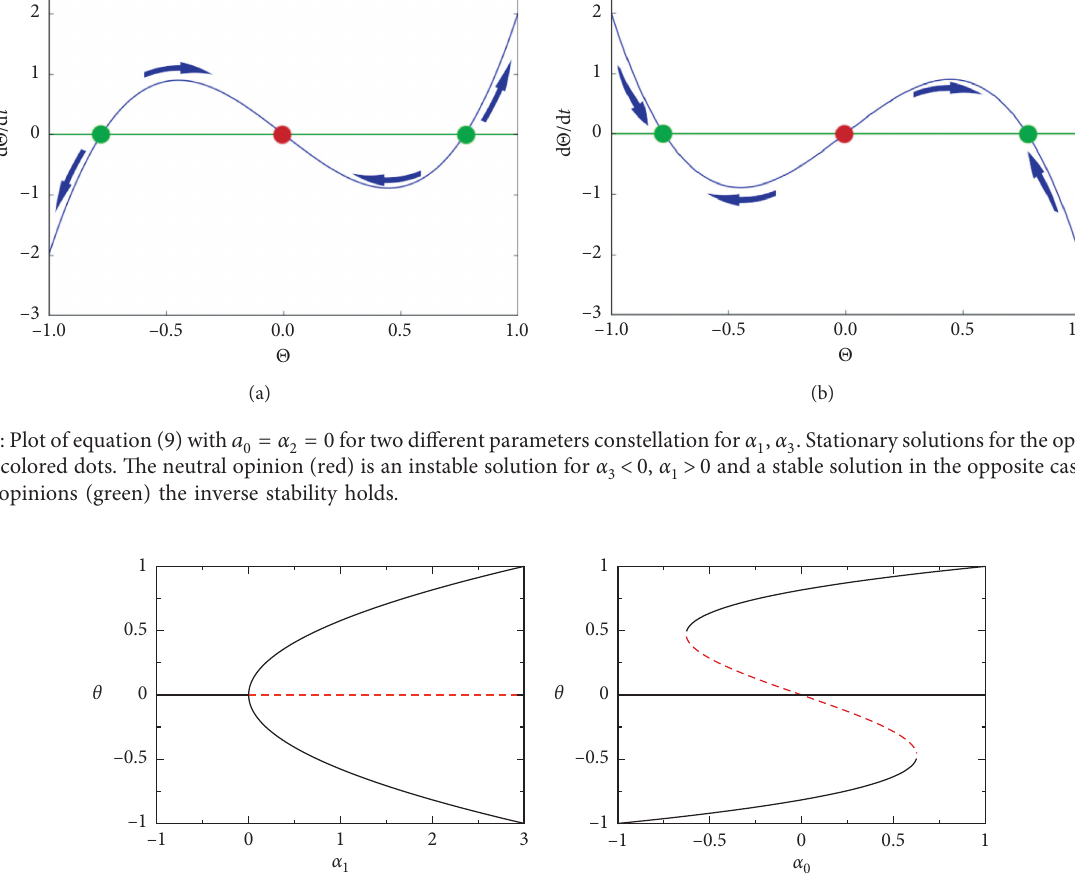
, α . Stationary solutions for the opinions are 1 3 < 0, α > 0 and a stable solution in the opposite case. For the 3 1